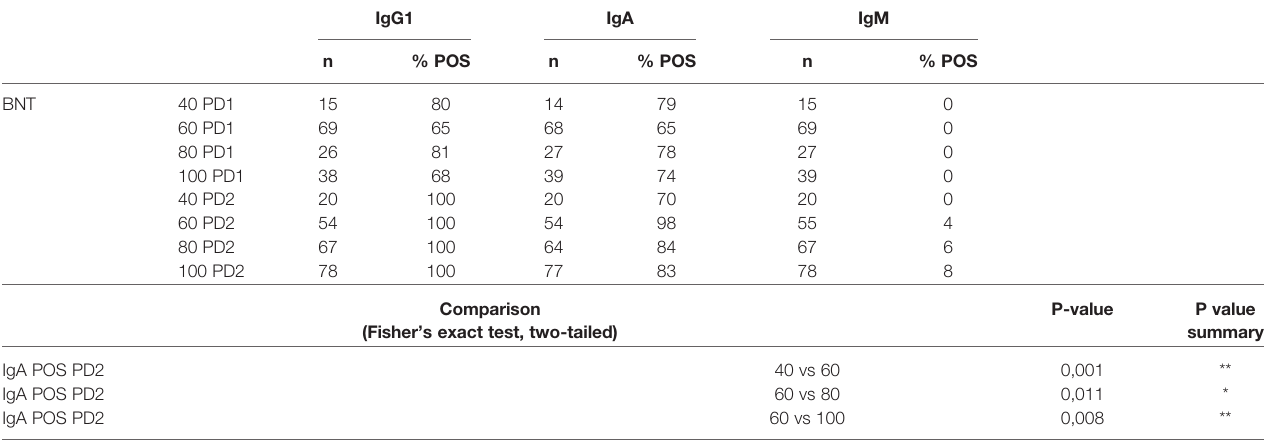
TABLE 1 | Total number and proportion of positive samples for IgG1, IgA and IgM after the administration of one or two doses grouped by the age of the donor.